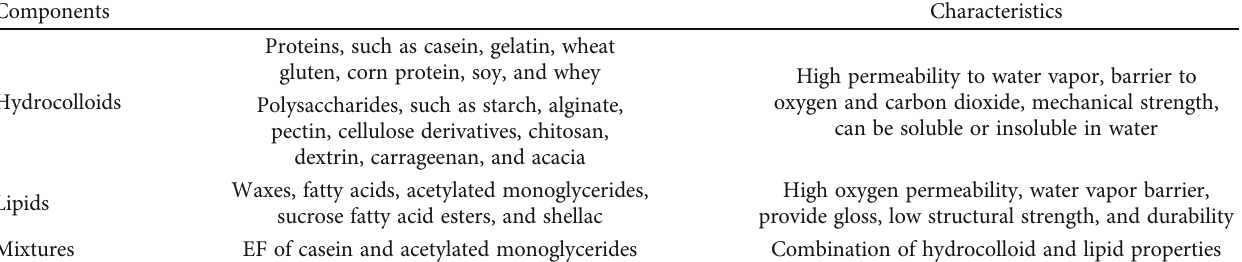
Table 2: The main components of edible fi lms and coatings (adapted from Espitia et al. [75]). Components